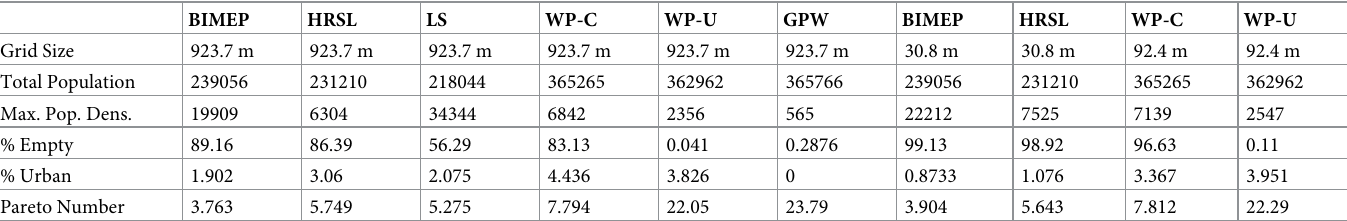
Table 1. Basic summary statistics for all the maps, including the grid size, total population, maximum population density at 1 km 2 , the percentage of pixels that were empty or urban (with > 1000 people per km 2 ), and the Pareto Number, defined as the percentage x that holds a percentage 1 − x of the population.